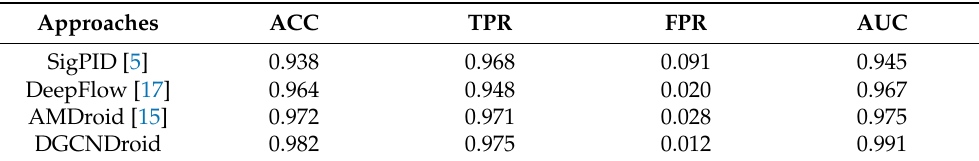
Table 6. Comparison of DGCNDroid with three existing methods.